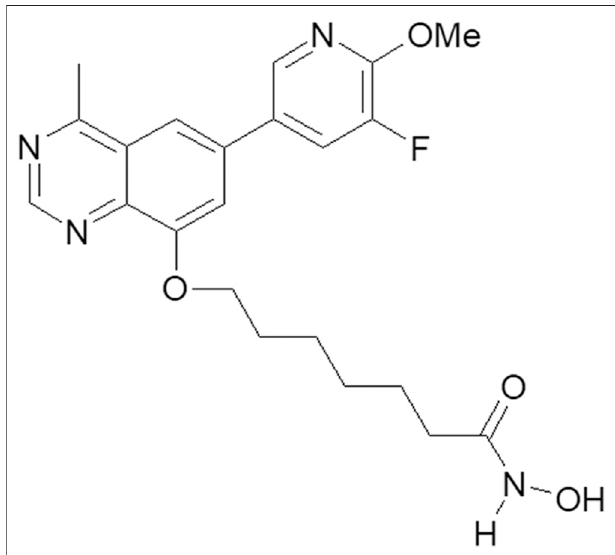
FIGURE 1 | The structure of compound